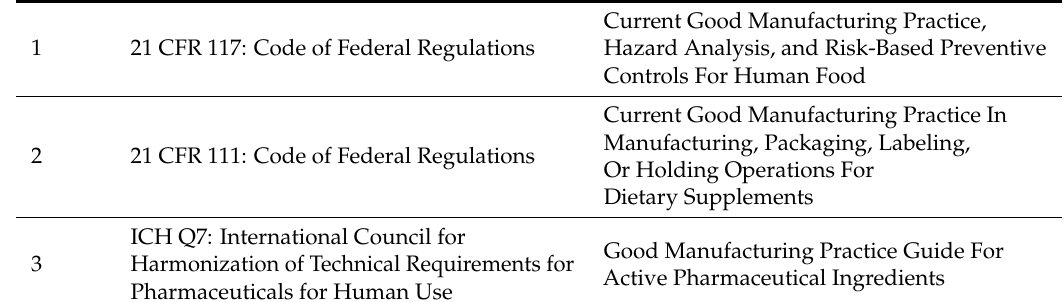
Table 2. Examples of regulatory guidelines for quality